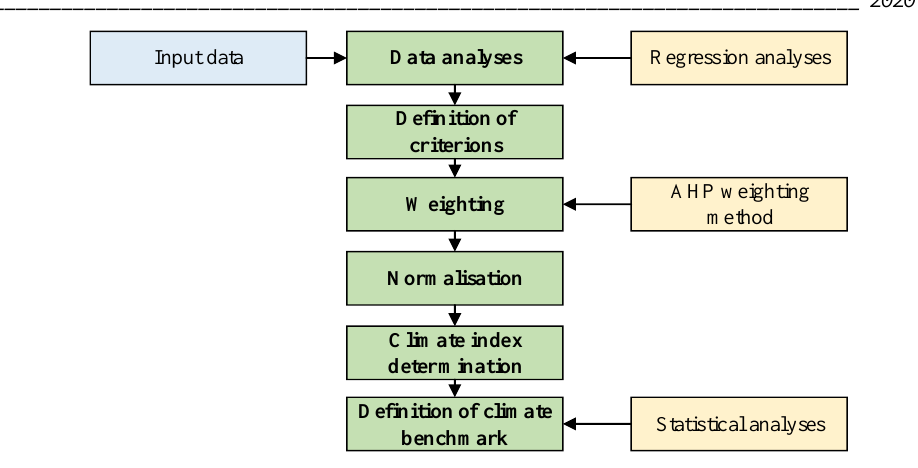
Fig. 1. Main steps and methods for determination of climate benchmark.